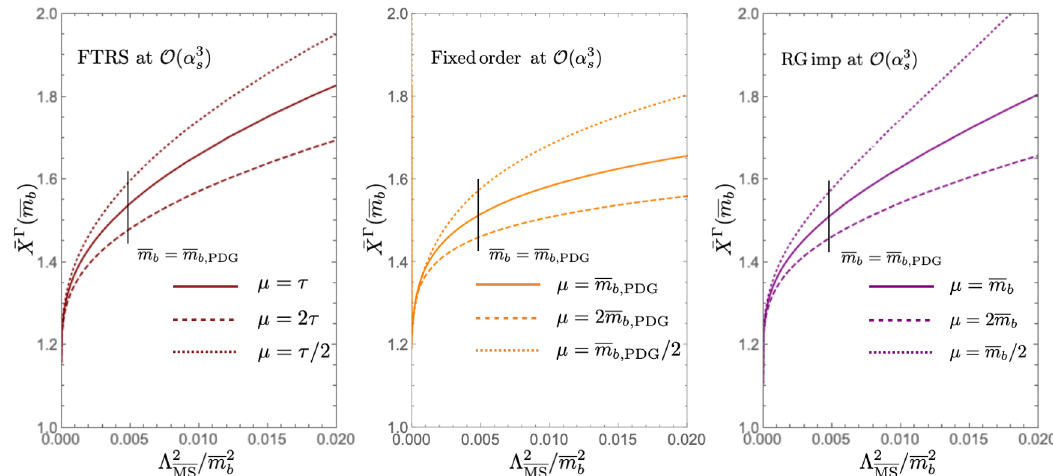
Figure 7 . Comparison of ¯ X Γ by FTRS method, and by fixed-order and RG-improved calculations up to order O ( α 3 ) . We take n f = 4 , Λ = 0 . 292 GeV and m c = 0 as inputs. We vary µ within s MS